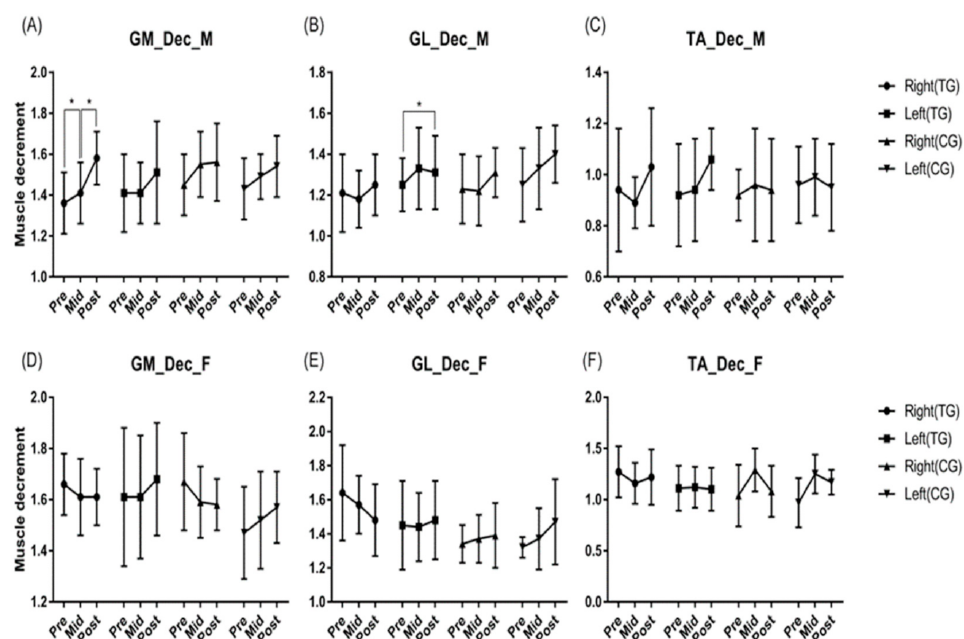
Figure 3. Effects of core balance training on muscle elasticity. There was difference according to time in men's right GM ( p < 0.001) and left GL ( p = 0.042). For women, there was a difference according to group time interaction in left GM ( p = 0.045) and right TA ( p = 0.027), and there was a difference according to group in right GL ( p = 0.016). * p < 0.05. Abbreviations: GM, gastronemius medial; GL, gastronemius lateral; TA, tibialis anterior; Dec, muscle decrement; M, male group; F, female group; Pre, pre-test; Mid, mid-test; Post, post-test; TG, training group; CG, control group. There was a difference in Stf according to time in men's right and left GM and left GL (p < 0.05). For women, there was a difference according to time in the right GM, right and left GL, and right TA (p < 0.05), and there was a difference based on the group type in the left TA (p < 0.05) (Figure 4).